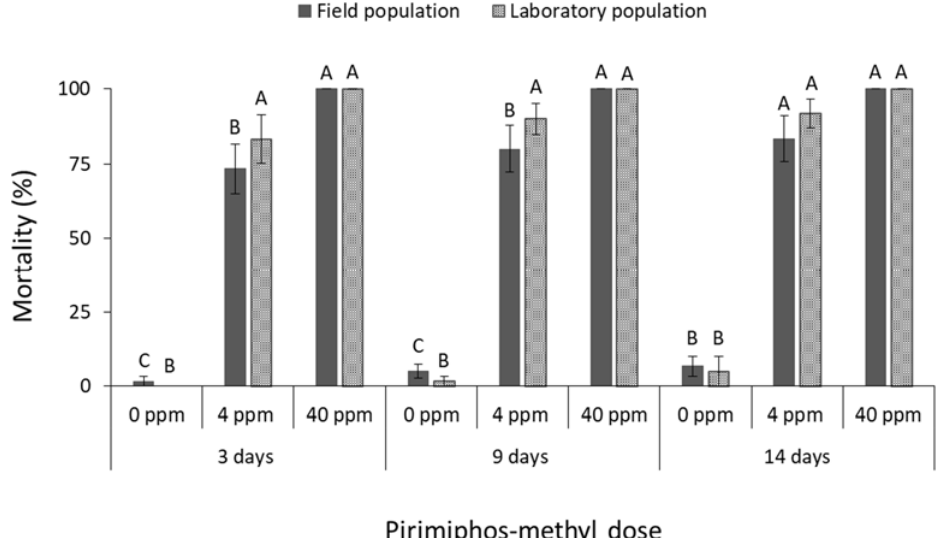
Figure 3. Mean (% ± SE) adult mortality of field and laboratory populations of R. dominica after 3, 9 and 14 days of exposure to different concentrations of pirimiphos-methyl (within each exposure interval and population, means followed by the same letter are not significantly different; where no letters are present, no significant differences were noted; HSD test a 0.05).